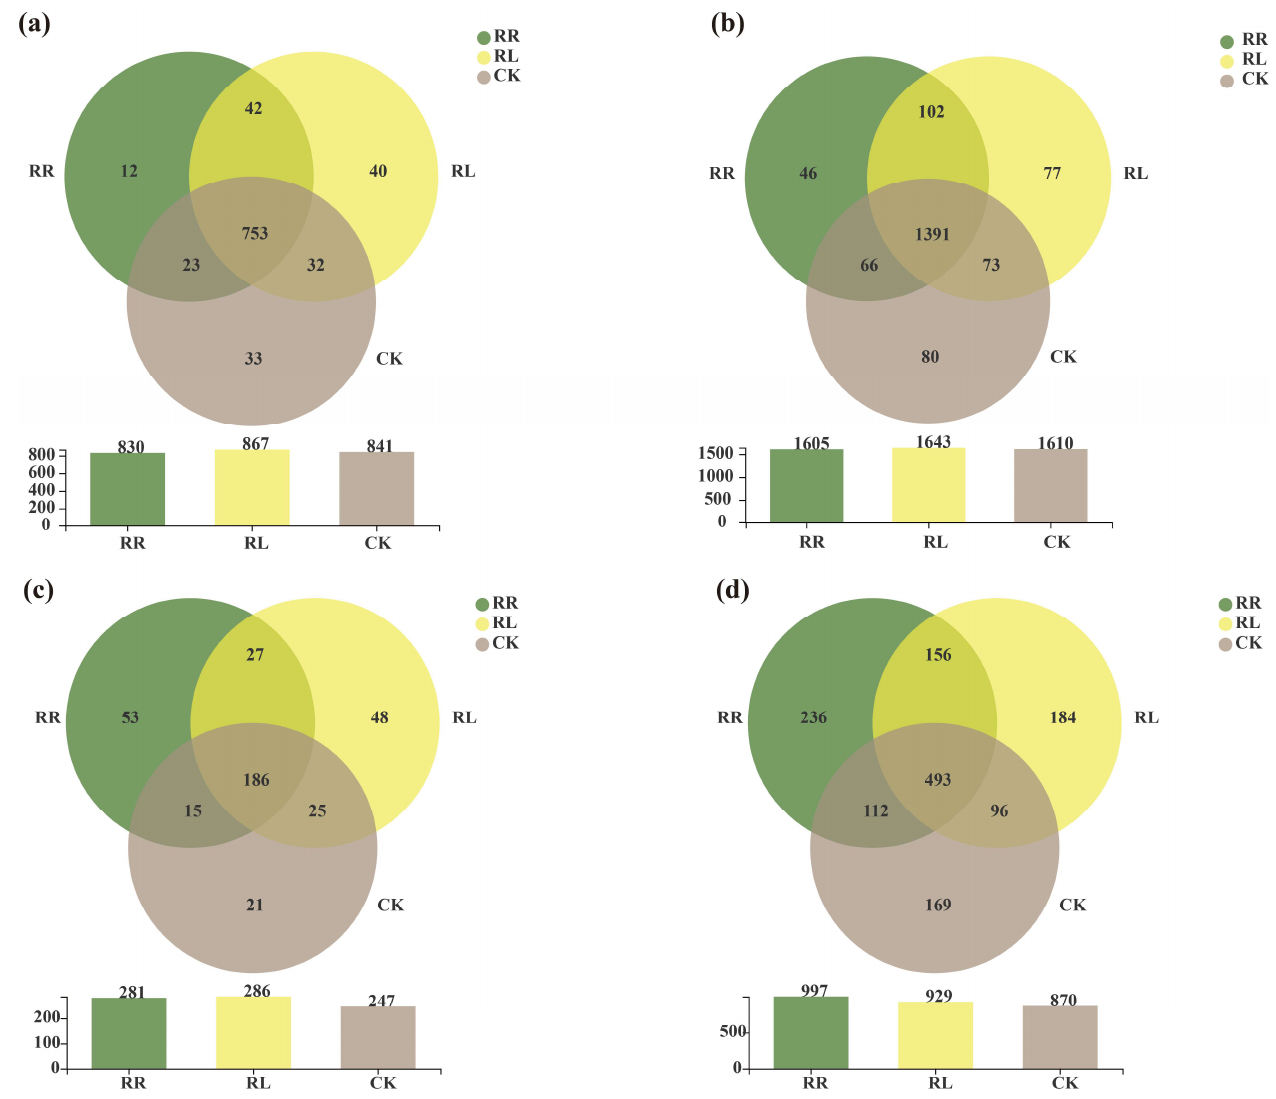
Figure 5. Venn diagram of soil bacteria in the oilseed rape rhizospheres in the monoculture (RR), intercropping system (RL) and CK. ( a ) Venn diagram of soil bacterial communities at the genus level; ( b ) Venn diagram of soil bacterial communities at the OTU level; ( c ) Venn of soil fungal communities at the genus level; ( d ) Venn diagram of soil fungal communities at the OTU level.